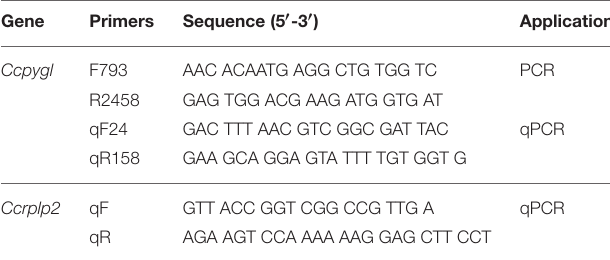
TABLE 2 | Primer sequences used in this study.